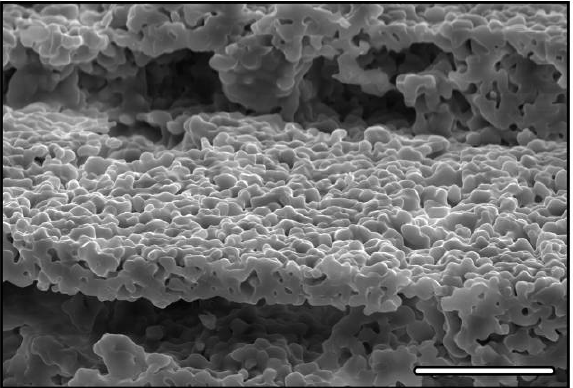
Figure 3. Microporosities in freeze-cast HAP. Scale bar 25 μ